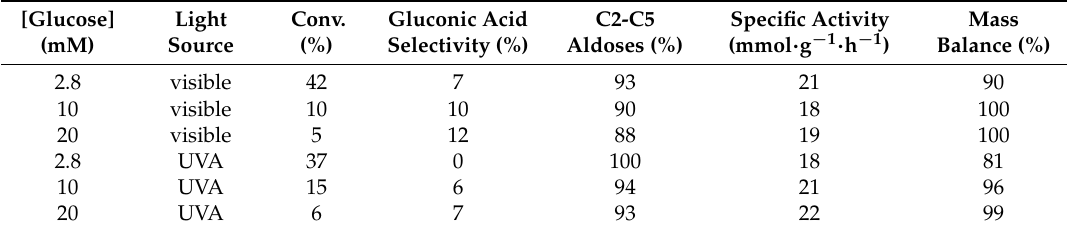
Table 3. Effect of various parameters for glucose photocatalytic conversion with TiO 2